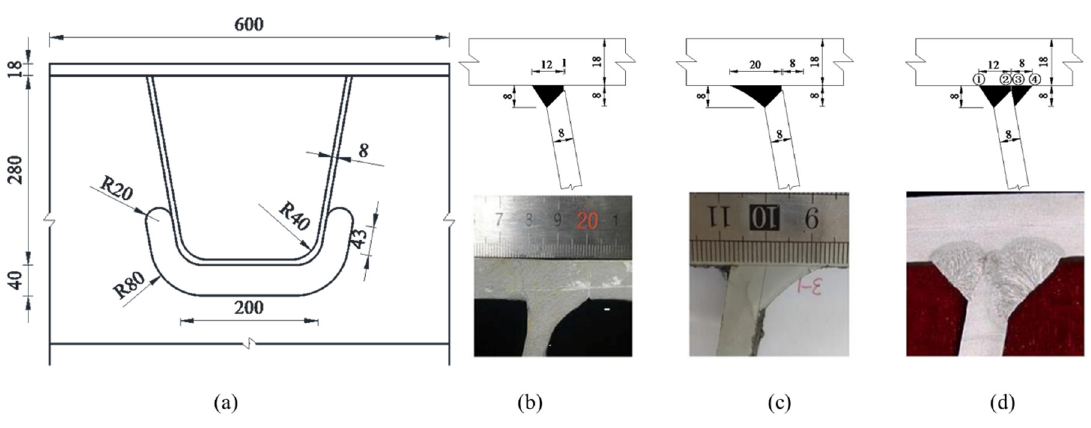
Figure 6. The detailed sizes (Unit: mm) of the orthotropic steel bridge deck (OSBD) and three typical connections. ( a ) Model of the OSBD; ( b ) traditional weld seam; ( c ) weld seam of large root; ( d ) double-sided weld. 1 (cid:79) weld toe of outer seam 2 (cid:79) weld root of outer seam 3 (cid:79) weld root of inner seam